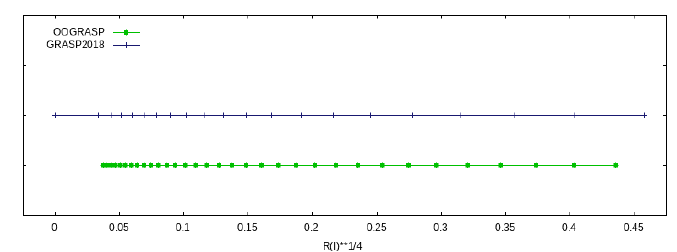
Figure 1. Figure showing the different distribution of the grid points plotted versus r 1/4 .